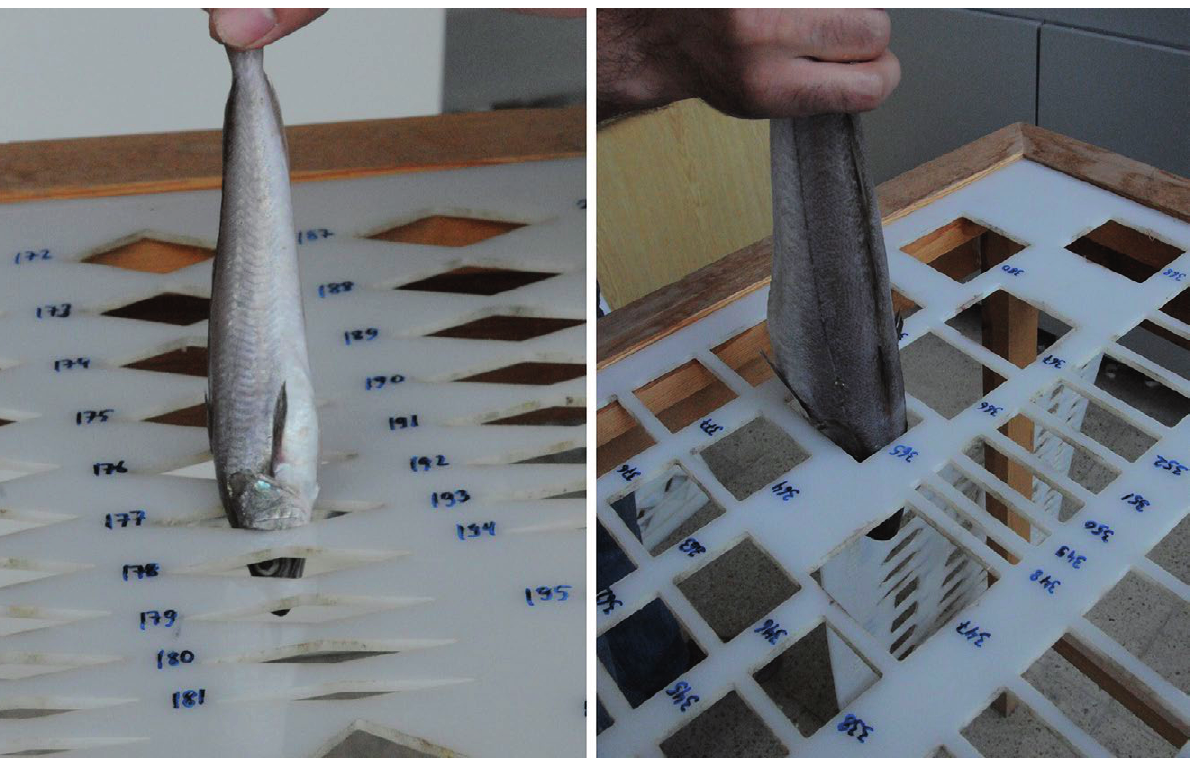
Fig. 3. – Fall-through experiments using stiff mesh templates of different mesh sizes and shapes. Left, example of diamond mesh template; right, example of square and rectangular mesh